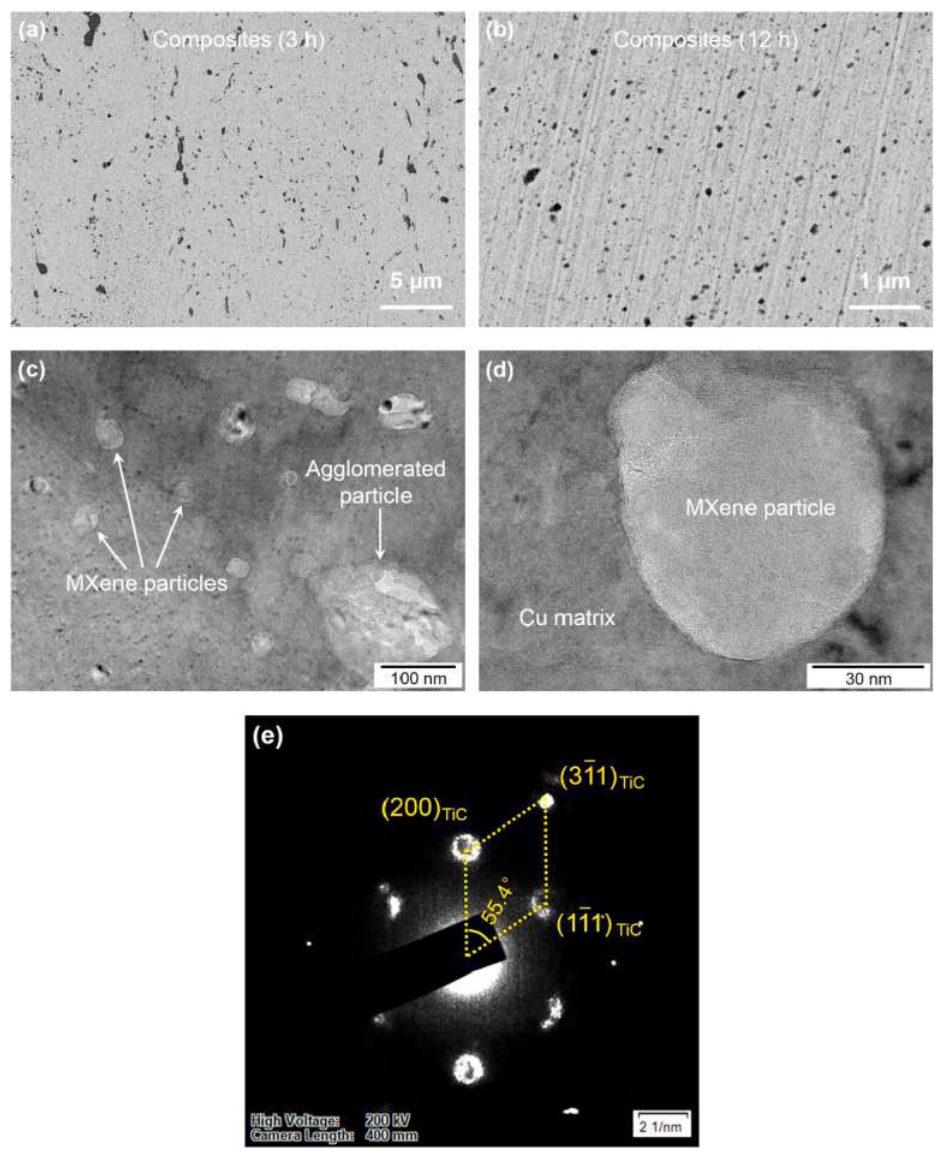
Figure 26. ( a , b ) The backscattered electron SEM images of microstructure of MXene/Cu composites: ( a ) 3MXene/Cu-12 h, ( b – e ) the TEM images of the microstructure of 3MXene/Cu-12 h, ( d ) the microstructure of the interface between one MXene nanoparticle and the Cu matrix, and ( e ) the selected area electron diffraction (SAED) pattern corresponding to the area of ( d ) [74]. The agglomerated particle is clearly made up of nanoscale MXene particles, as can be seen. The microstructure backs up the results from the SEM in Figure 25f. Figure 26d depicts the microstructure of the contact linking the single nanoscale MXene fragment and the Cu grid. The interface was clean, with no contaminants or flaws present, indicating robust interfacial adhesion. Figure 26e demonstrates that the SAED specimen is comparable to the region in Figure 26d. The dispersed particles had asserted to be cube-like TiC composition based on the calibration outcomes of the diffraction spots. MXene's stability was highly connected to the tempering heat, as previously stated. The MXene/Cu complex had been synthesized at temperatures exceeding 1040 °C for more than 50 min, allowing the original MXene to convert entirely into a cubic TiC structure. For the time being, it is still referred to as MXene particles due to the unknown stoichiometry of the newly synthesized cube-like TiC, and particularly it had changed from MXene. The powdered MXene–Cu complex was added to a glazed graphite mold,